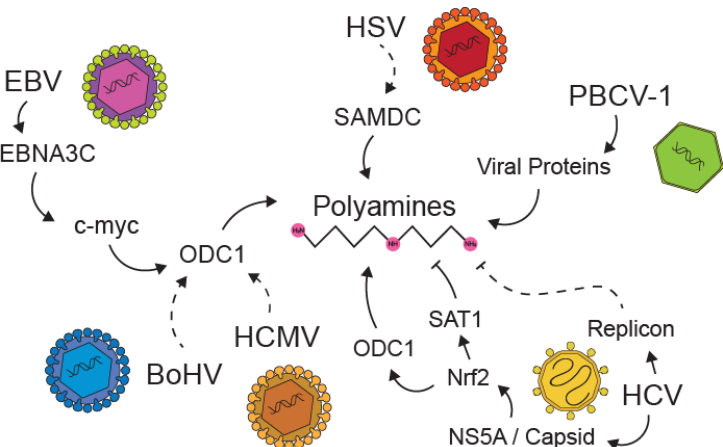
Figure 4. Viral manipulation of polyamines in infected cells. The herpesvirus Epstein–Barr virus (EBV), herpes simplex virus (HSV), bovine herpesvirus (BoHV), and human cytomegalovirus (HCMV) induce polyamine levels through ODC1 and SAMDC. Hepatitis C virus (HCV) proteins induce both SAT1 and ODC1, and cells harboring HCV replicons exhibit reduced levels of polyamines. Paramecium busaria chlorella virus (PBCV-1) encodes a polyamine biosynthetic pathway. Mechanisms that are not fully understood are represented by dashed lines.